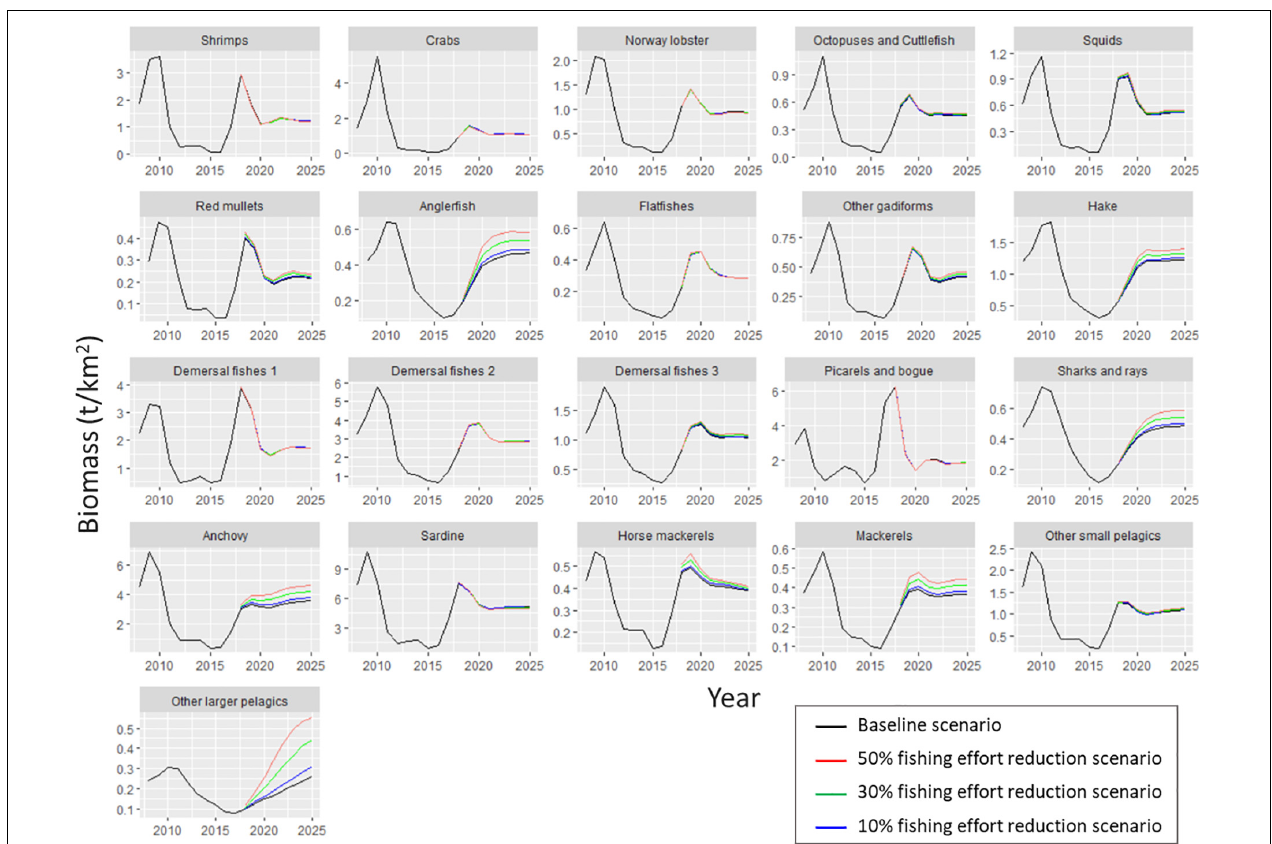
FIGURE 7 | Biomass predicted by the Ecosim model for each functional group of Pagasitikos Gulf from 2008 to 2025, according to the business as usual scenario (black line) and three scenarios of reduced fishing effort by 10% (blue), 30% (green), and 50%